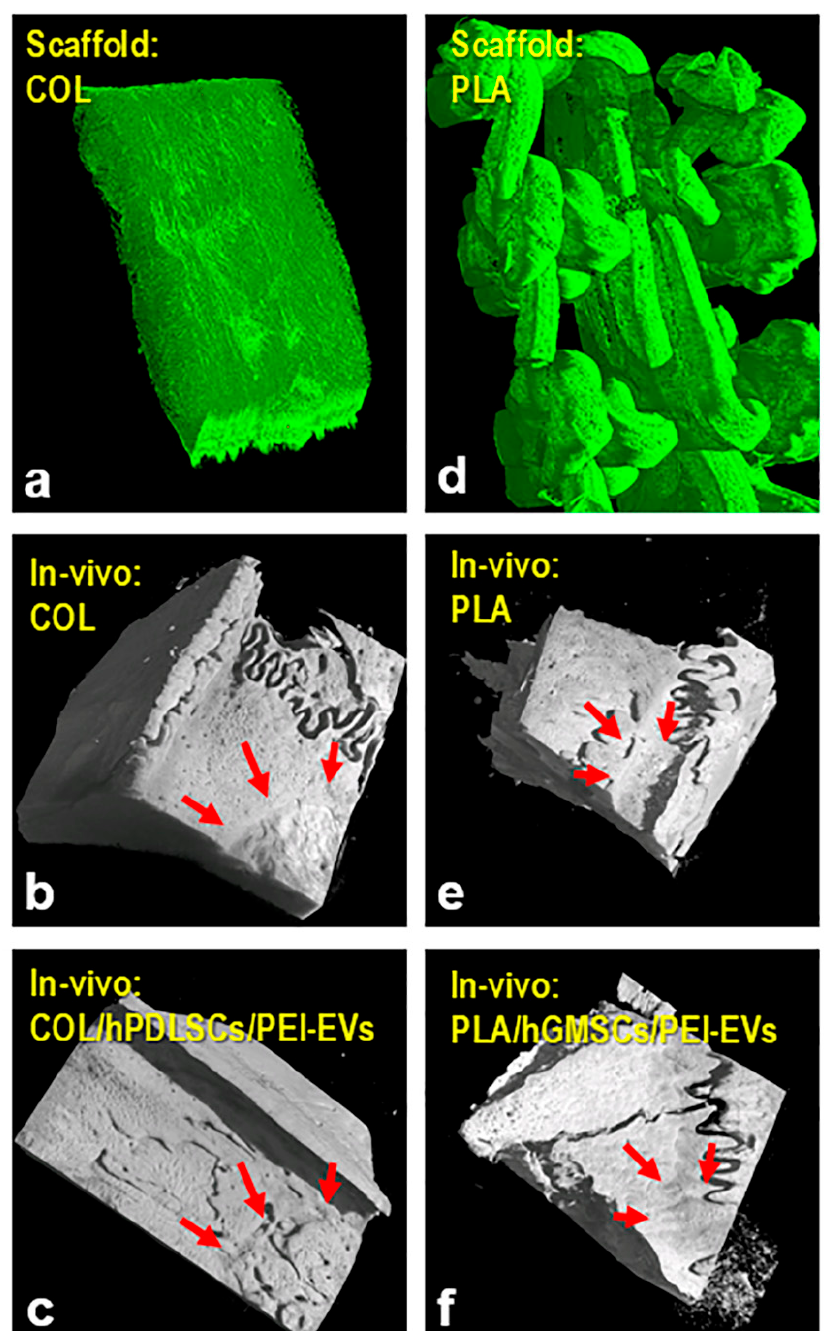
Figure 1. Phase-contrast MicroCT 3D images of representative samples. ( a ) Collagen membranes (COL) scaffold before grafting; ( b , c ) repaired calvarial defects: ( b ) representative sample of the COL group; ( c ) representative sample of the COL/hPDLSCs/PEI-EVs group; ( d ) poly-(lactide) scaffold (PLA) scaffold before grafting; ( e , f ) repaired calvarial defects: ( e ) representative sample of the PLA group; ( f ) representative sample of the PLA/hGMSCs/PEI-EVs group. Red arrows indicate the defect site in each panel. Phase-contrast signal (grey cloud of points) close to the defects repaired using PLA- based constructs represents PLA residuals.